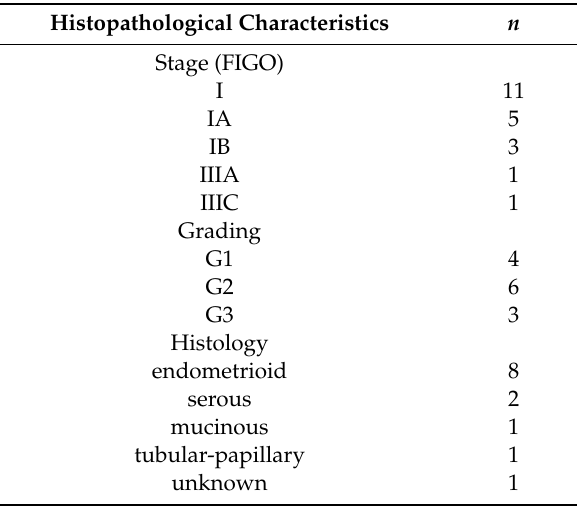
Table 2. Histopathological characteristics.